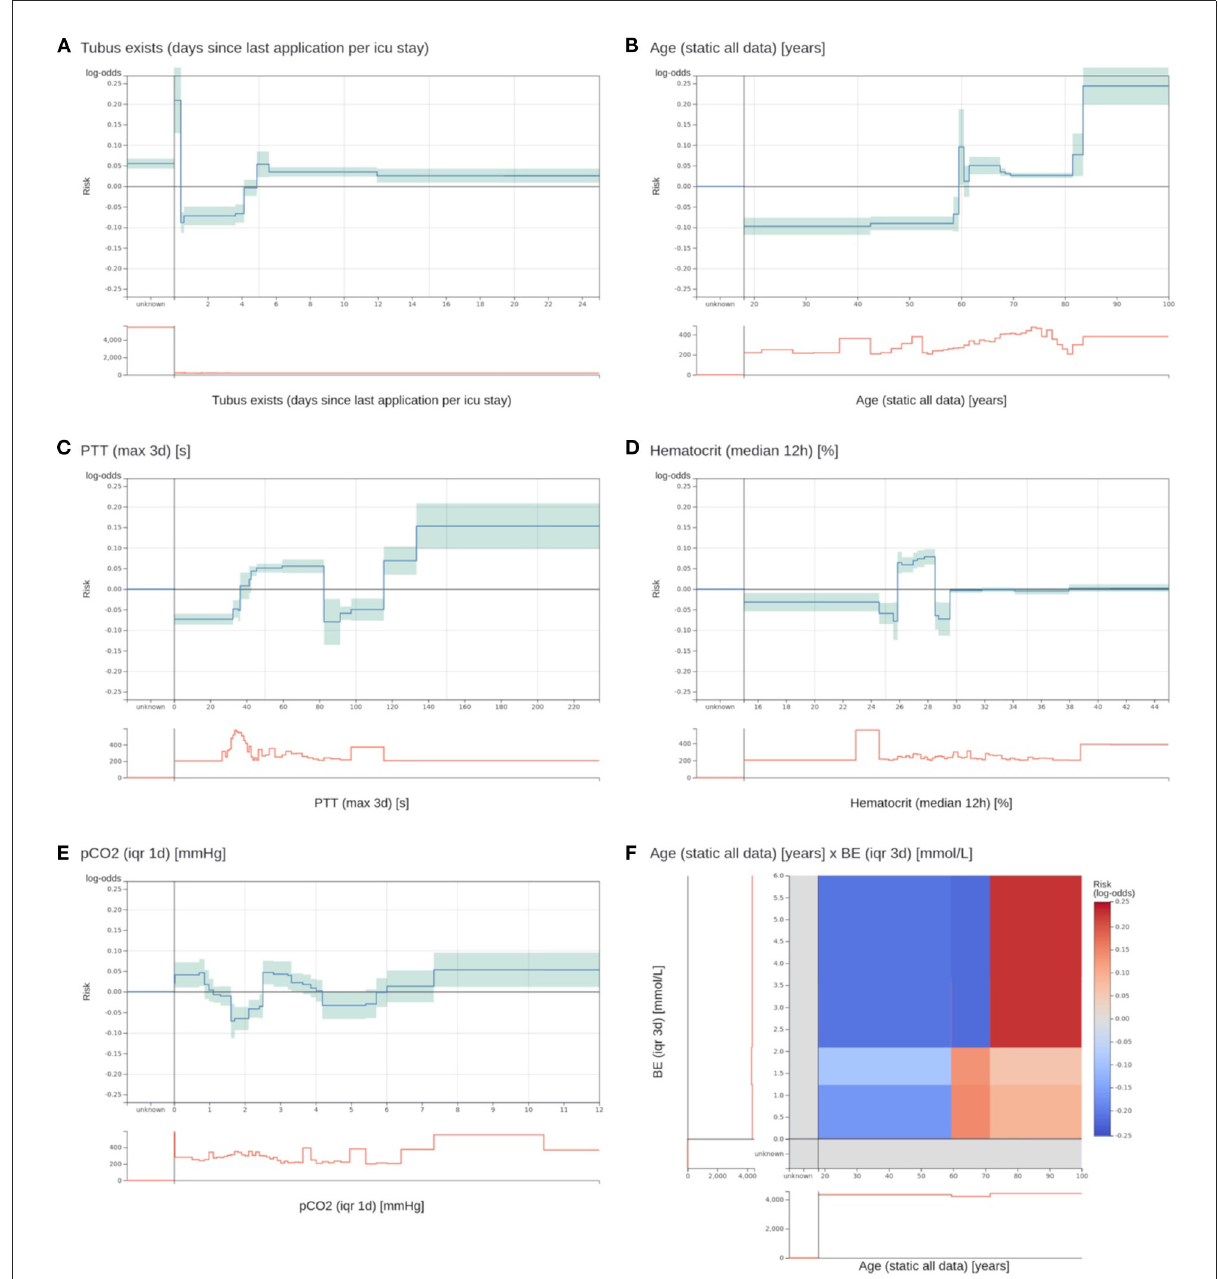
FIGURE3 Two most important risk functions and four excluded risk functions of the EBM model. (A,B) Two most important risk functions that are included in the EBM model. (A) Contains the number of days since the last existence of an endotracheal tube. Patients that have an endotracheal tube immediately before discharge have a highly increased risk. Lower risk is assigned to values between 0.4 and 4.1 days. Also, patients with no endotracheal tube (unknown) receive an increased risk. (B) The risk function for age shows an increased risk for higher age values. There is a peak at 60 years with no obvious explanation. (C) A maximum PTT value over the last 3 days before discharge between 82.5 and 115.5s gets a lower risk for 3 day ICU readmission. It was identified that this is an artifact of the previous procedure to determine the PTT for cardiac surgery patients. This will not generalize for future data. (D) For a median hematocrit between 24.875 and 28.525%, the model determined an elevated risk. For slightly lower and higher values, the risk is negative. This is against common medical knowledge, where a decreasing hematocrit value should be associated with increased risk. (E) The interquartile range (IQR) of the partial pressure of carbon dioxide (pCO2) over the last day before discharge receives an increased risk for values between 0 and 0.863 and 2.513 and 3.313 mmHg. However, the interpretation of this behavior and determining its clinical implications was impossible. (F) The 2D risk function for age and the IQR of the base excess (BE) over 3 days. Patients over 71.5 years have a high risk for a high IQR of the BE. Patients between 59.5 and 71.5 have only a slightly increased risk for low IQR values, and younger patients have a decreased risk across all BE values. The team excluded it due to a lack of